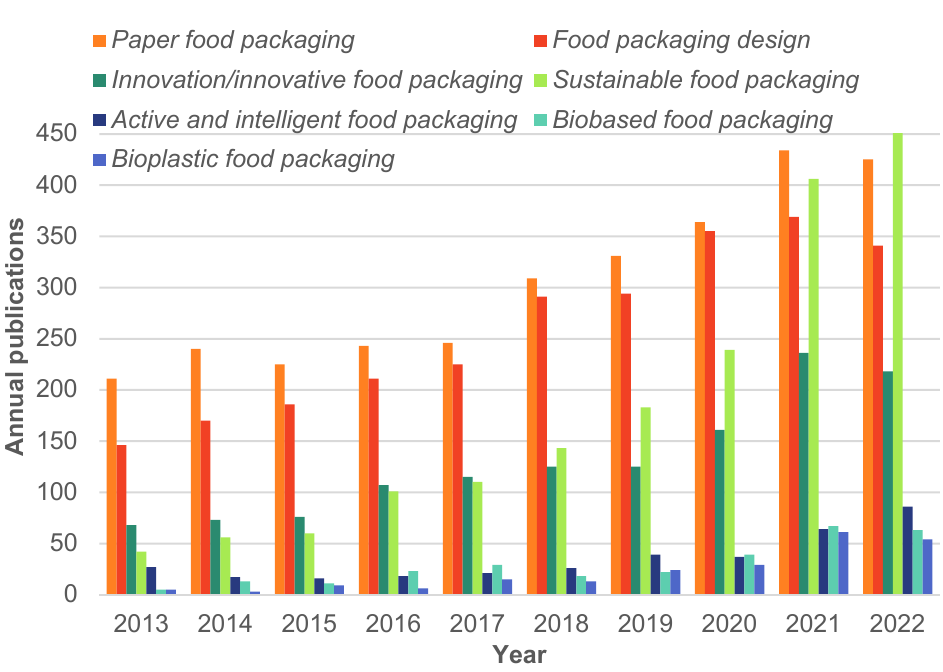
Figure 1. Total number of publications reported in literature in the last ten years on food packaging for specific keywords. Literature review carried out on Scopus search engine of bibliographic databases.